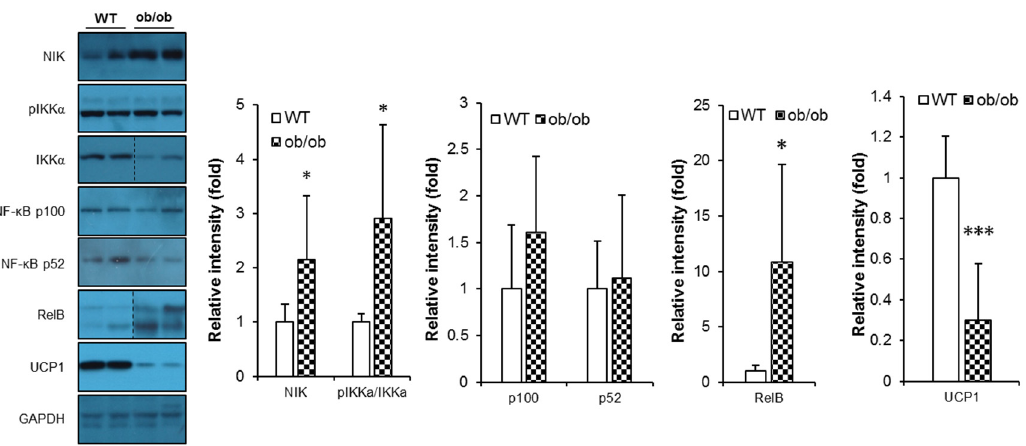
Figure 6. BAFF signaling is up-regulated in brown and subcutaneous adipose tissues of ob/ob mice. Effect of leptin deficiency on protein levels of BAFF signaling molecules and UCP1 in brown adipose tissue ( n = 6–8). Proteins were extracted from the tissue for SDS-PAGE-immunoblot analysis. Data represent means ± SD. * p < 0.05 and *** p < 0.001 between wild-type and ob/ob mice.